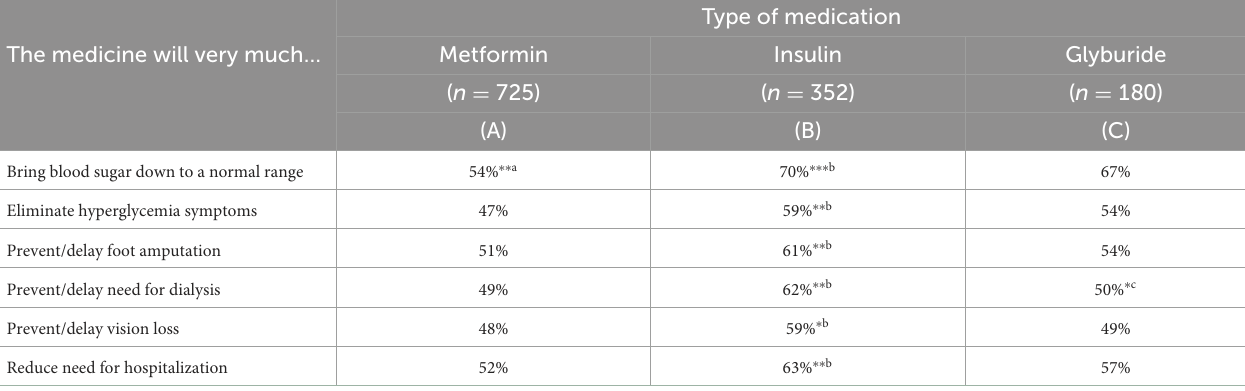
TABLE 3 Realistic expectations according to type of